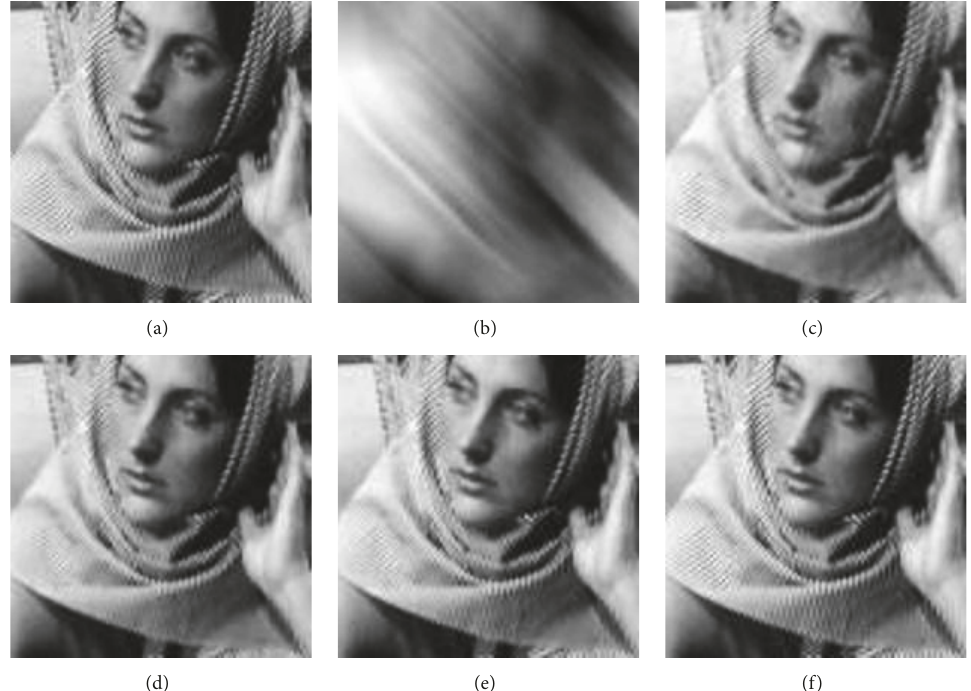
Figure 8: The zoomed regions of the results of Figure 7. (a) Original image; (b) blurred and noisy image; (c) image recovered by FTVd; (d) image recovered by TGV; (e) image recovered by TVframe; (f) image recovered by